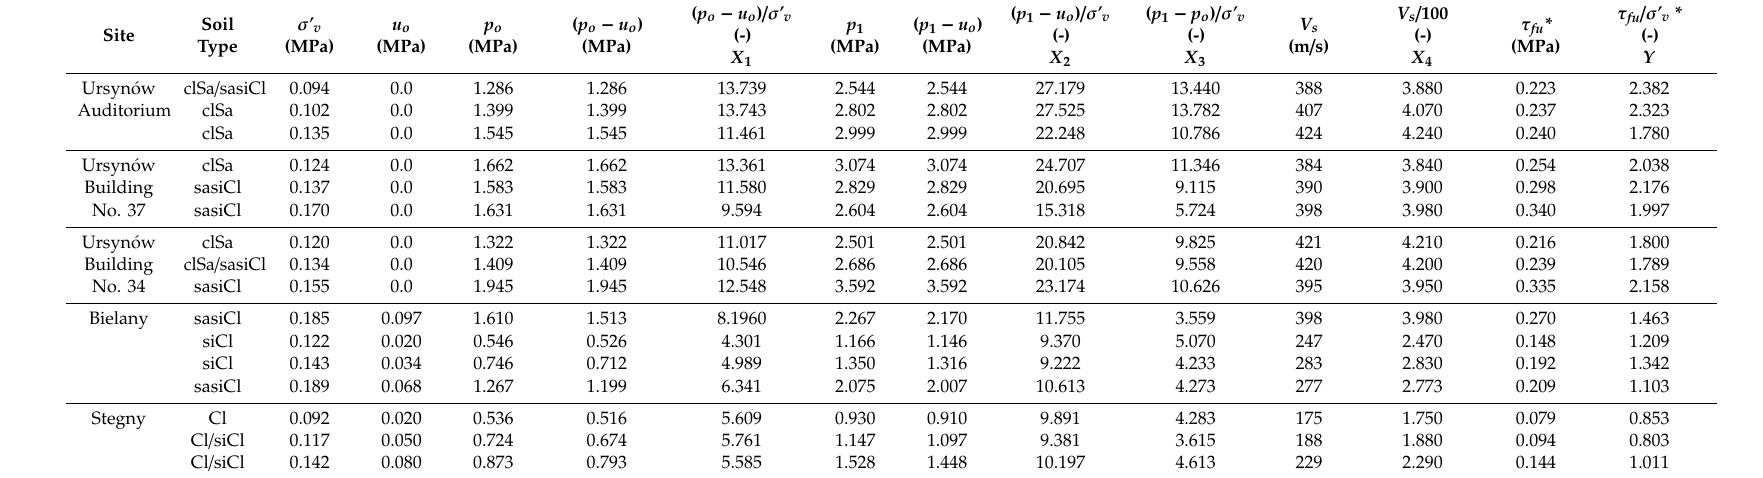
Table 4. Input and output values for the statistical